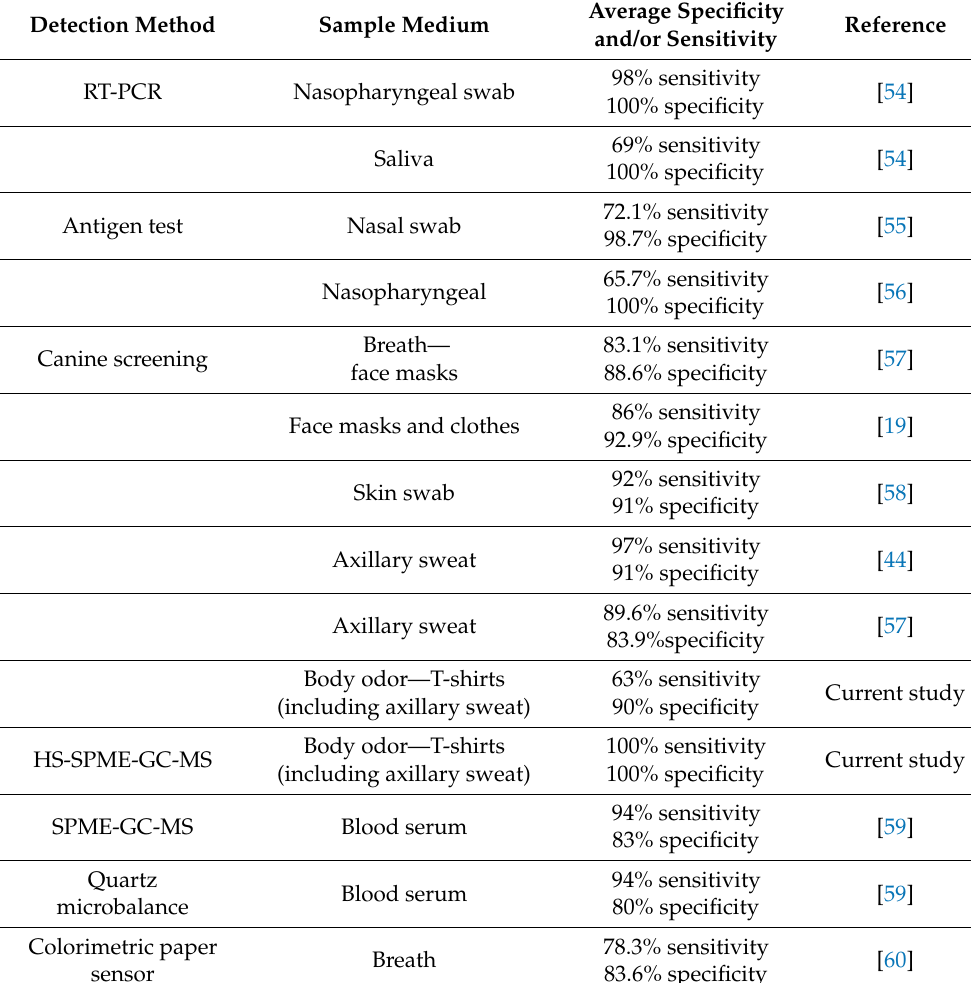
Table 7. COVID-19 detection method